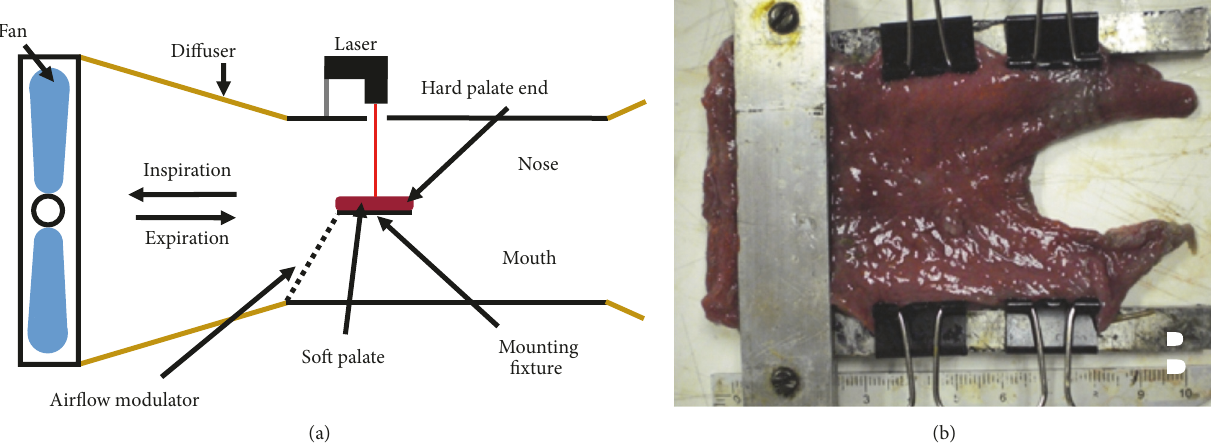
Figure 1: Wind tunnel apparatus. A wind tunnel was constructed to simulate simplified human or equine inhalation or exhalation airflow (a) consisting of a fan that blew air over the soft palate, an airflow modulator, and a laser micrometer to measure soft palate displacements. The soft palate was constrained (b) on the hard palate and lateral